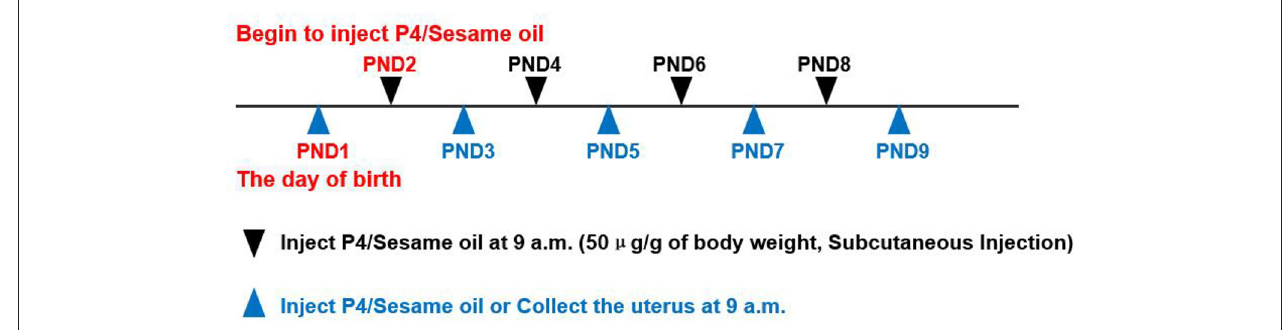
FIGURE 1 | Progesterone(P4)/Sesame oil injection method and the time points of collecting uterus. PND1 = Postnatal Day 1, can deduce the rest from this. P4 = Progesterone. Use a microsyringe (HAMILTON,702 RN,25 µ l, P/N:7636-01/00) for injection.